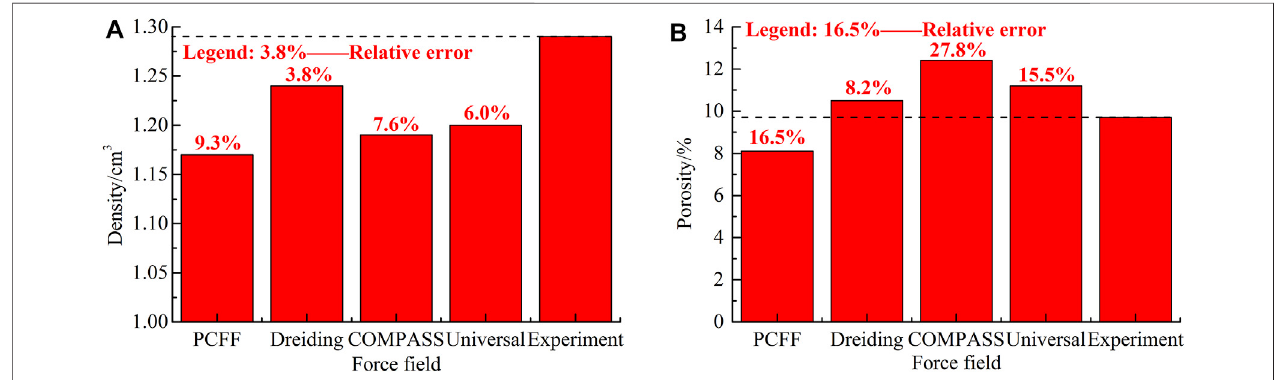
FIGURE 3 | Comparisons in the density (A) and porosity (B) of coal calculated from different force fi elds.